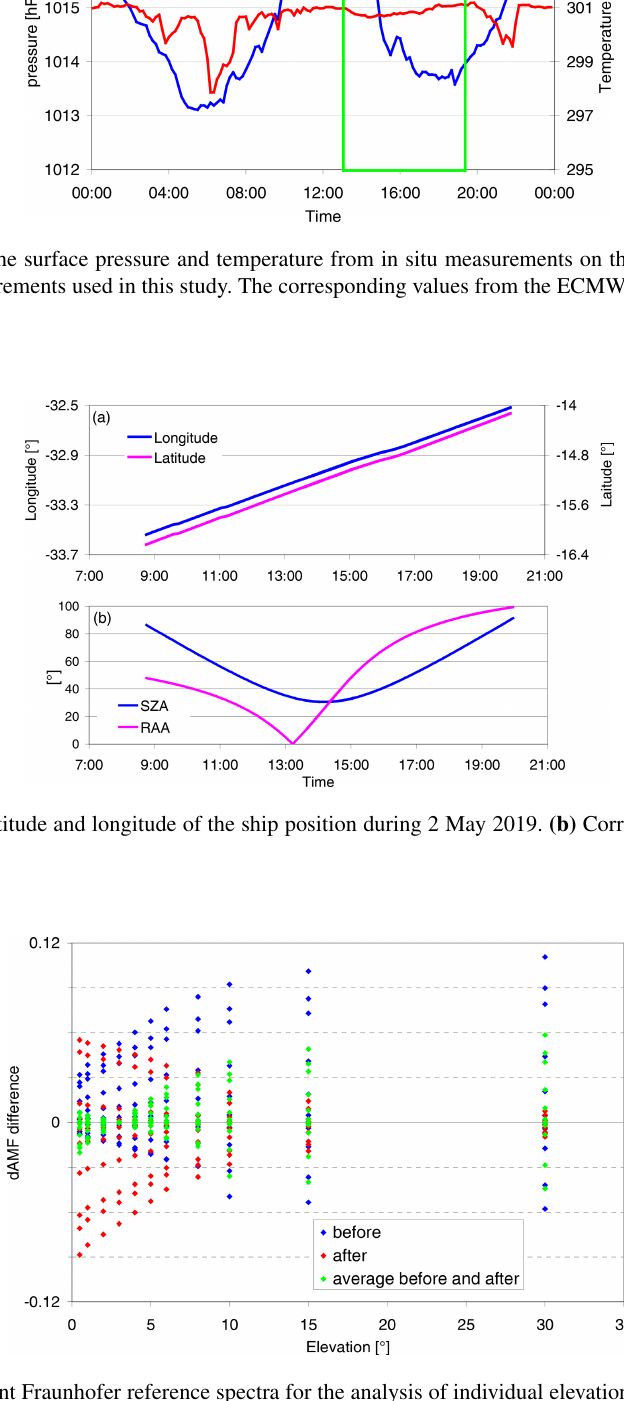
Figure A7. Effect of using different Fraunhofer reference spectra for the analysis of individual elevation sequences. Shown are the ratios of the obtained O 4 dSCDs for different selections versus those for Fraunhofer reference spectra interpolated between the zenith measurements before and after the selected elevation sequence. Before: zenith measurement before the sequence is used; after: zenith measurement after the sequence is used; average before and after: the average of the zenith measurements before and after the sequence is